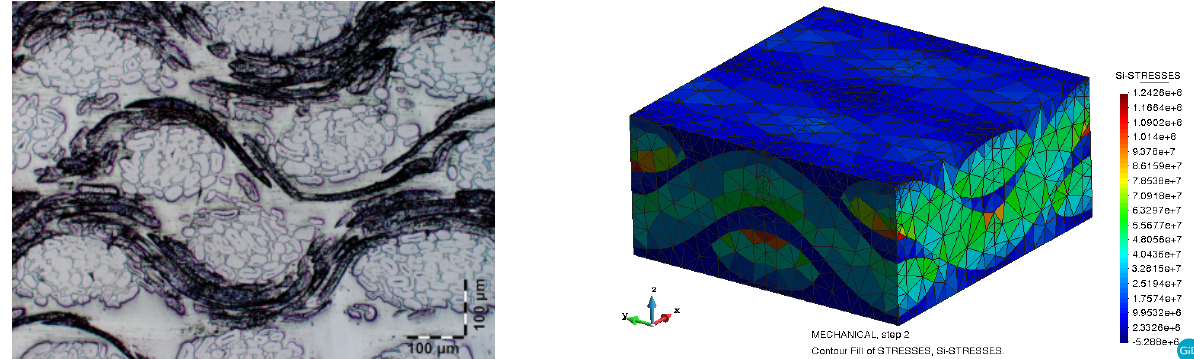
Figure 3. Microphotography of the ramie-woven skin and stresses obtained in the RVE model developed for its characterization when it is subjected to tensile loading.